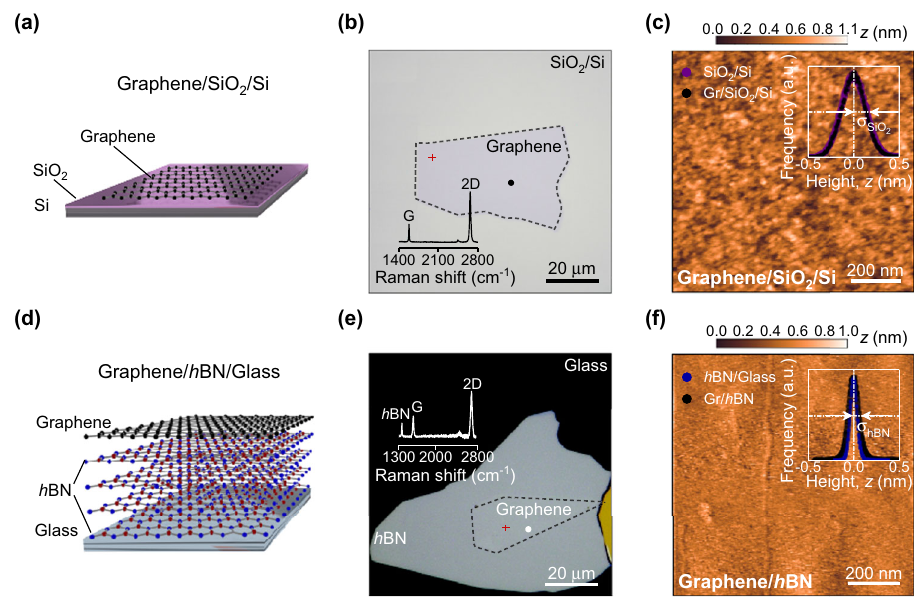
Fig. 1 Surface morphology of monolayer graphene on various substrates. a Schematic illustration and b ×50 optical image of graphene on SiO 2 /Si substrate. Dashed lines are a guide to eye-emphasizing fl ake boundaries. Inset demonstrates obtained Raman spectrum taken from the point speci fi ed by the black dot in ( b ). c Atomic force microscopy (AFM) color map taken from the region speci fi ed by the red cross in ( b ). The color bar shows the surface roughness. Inset shows histograms of the height distribution (surface roughness) for the substrate (SiO 2 /Si) and the fl ake (graphene). d Schematic illustration and e ×50 optical image of graphene on h BN/glass substrate. Dashed lines are a guide to eye-emphasizing fl ake boundaries. Inset demonstrates obtained Raman spectrum taken from the point speci fi ed by white dot in ( e ). f AFM color map taken from the region speci fi ed by the red cross in ( e ). The color bar shows the surface roughness. Inset shows histograms of the height distribution (surface roughness) for the substrate ( h BN/glass) and the fl ake (graphene).